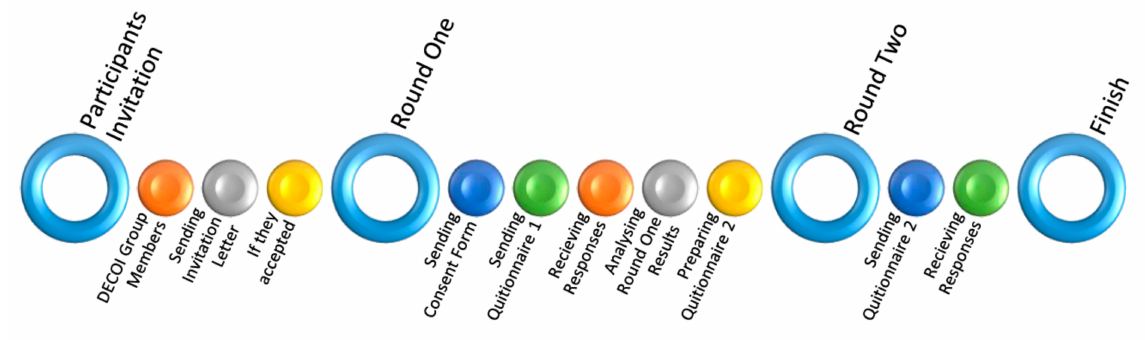
Figure 2. The adapted Delphi processes.